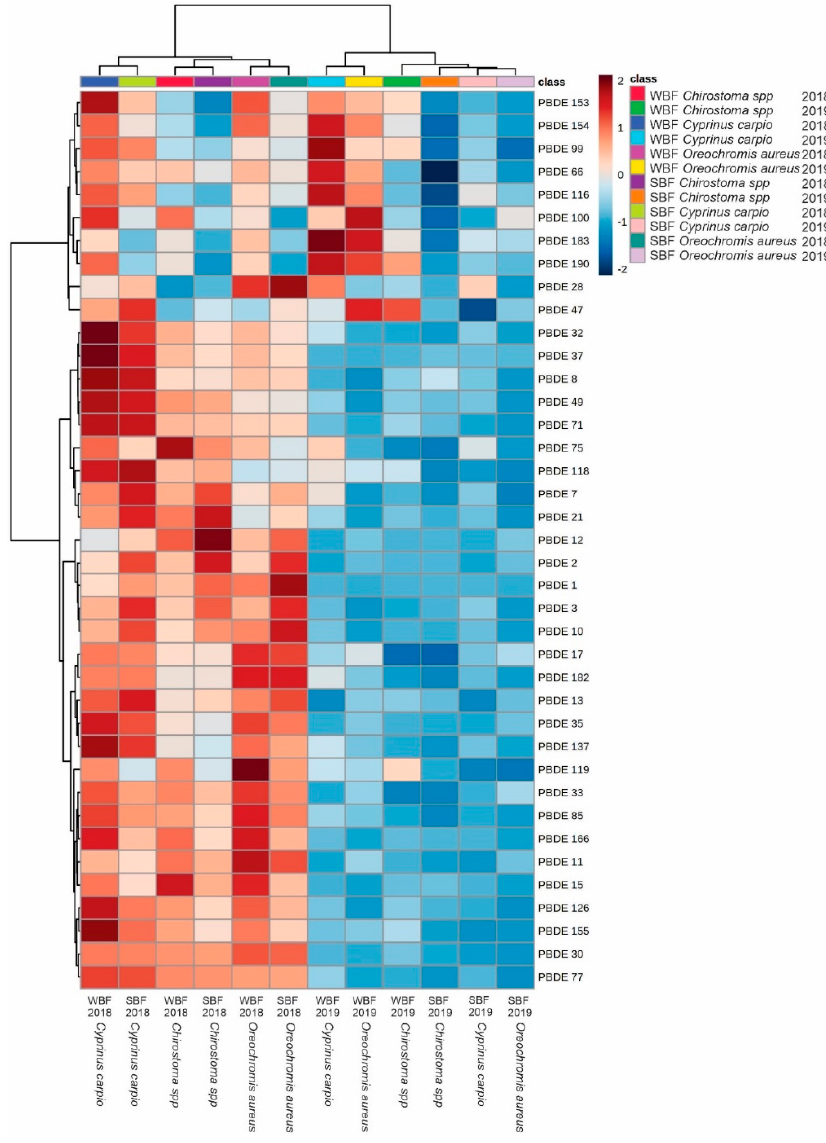
Figure 3. Heat map graph with hierarchical groupings for bioconcentration factors of PBDEs in fish from Lake Chapala. In the upper part groupings with respect to the samples. On the left side group ‐ ings between analytes. FBS: bioaccumulation factor with respect to sediments. FBA: bioaccumulation factor with respect to water. The color scale represents the normalized bioaccumulation values depending on the samples; an intense red color represents a high value, while an intense blue color represents a low level. Distance measure: Euclidean. Clustering algorithm: ward. t ‐ test/ANOVA.